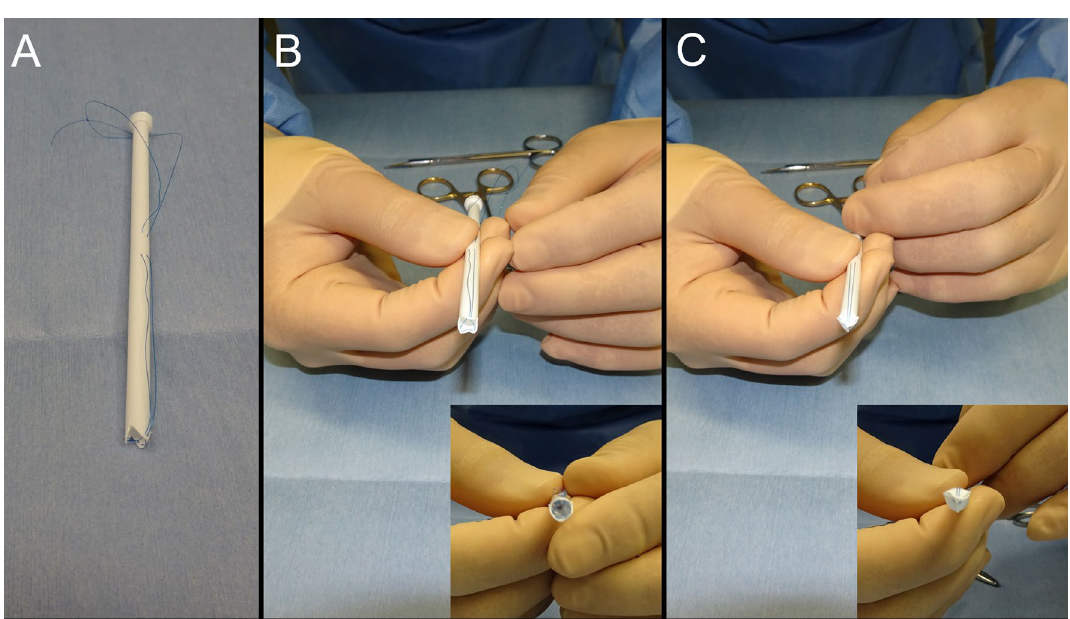
Figure 3. Modified angiographic catheter introducer: a cylindrical biopsy tool ( A ). Open ( B ) and close ( C ) position of the tool tip (achieved through a